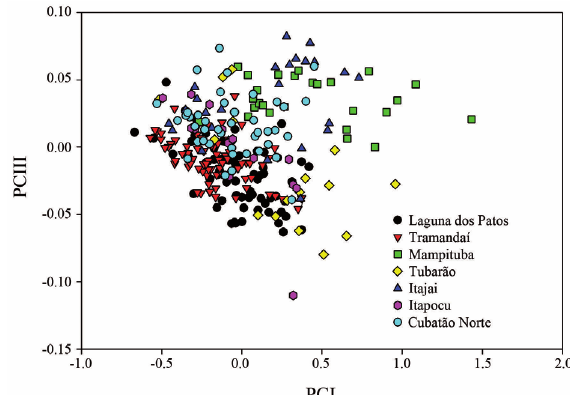
Fig. 12. Projection of individual scores in the space of first and third Principal Component axis for the populations of males and females of Astyanax laticeps .